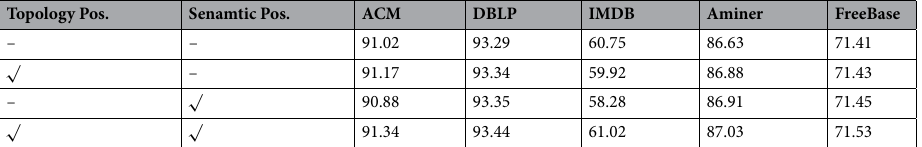
Table 5. Ablation study of positive sampling strategy on node classification with four variants; specific type of positives are selected.